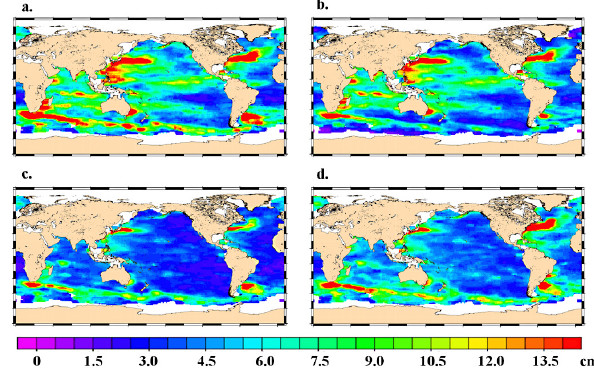
Fig. 3. Rms of SLA (a) , of DHA (b) and of the differences (SLA- DHA) when DHA are calculated from Argo T / S profiles (c) and of the differences (SLA-DHA) when DHA are calculated from Argo T profiles and S profiles from the WOA05 climatology (d)